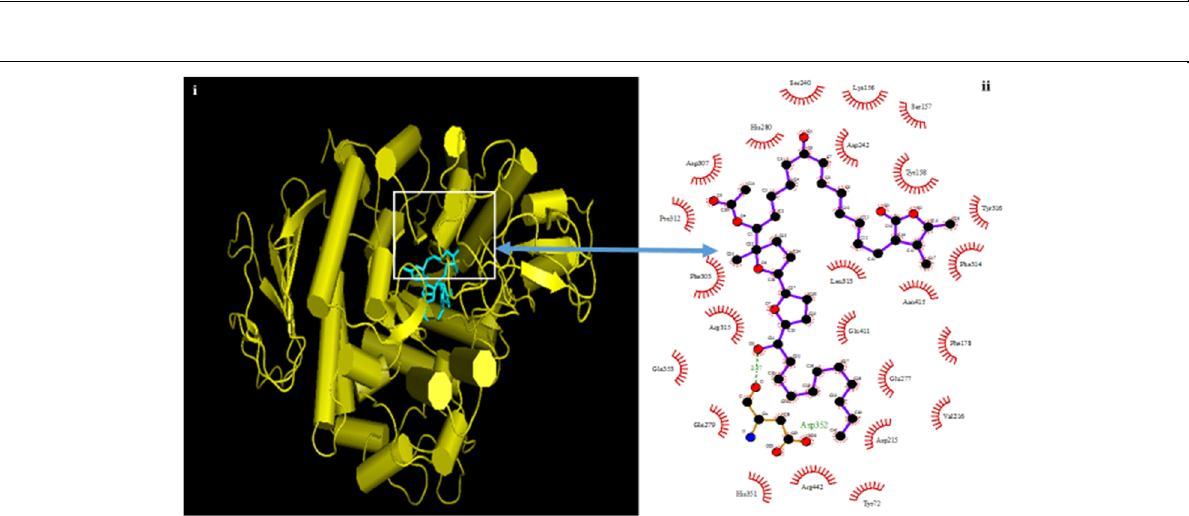
Fig. 17 The Binding pose of metformin at the active site of α -amylase with a binding energy of − 4.90 kcal/mole (i), and molecular interaction of metformin with amino acid residues within the active site of α -amylase (ii)